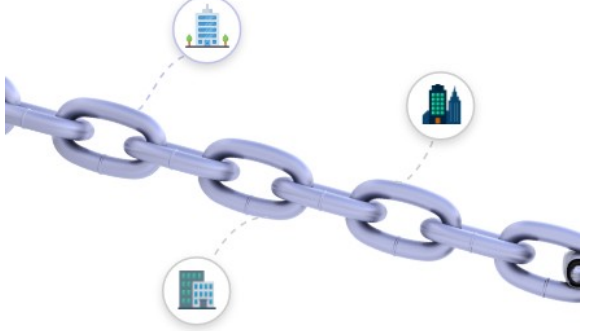
Figure 14. Blockchain in real estate.